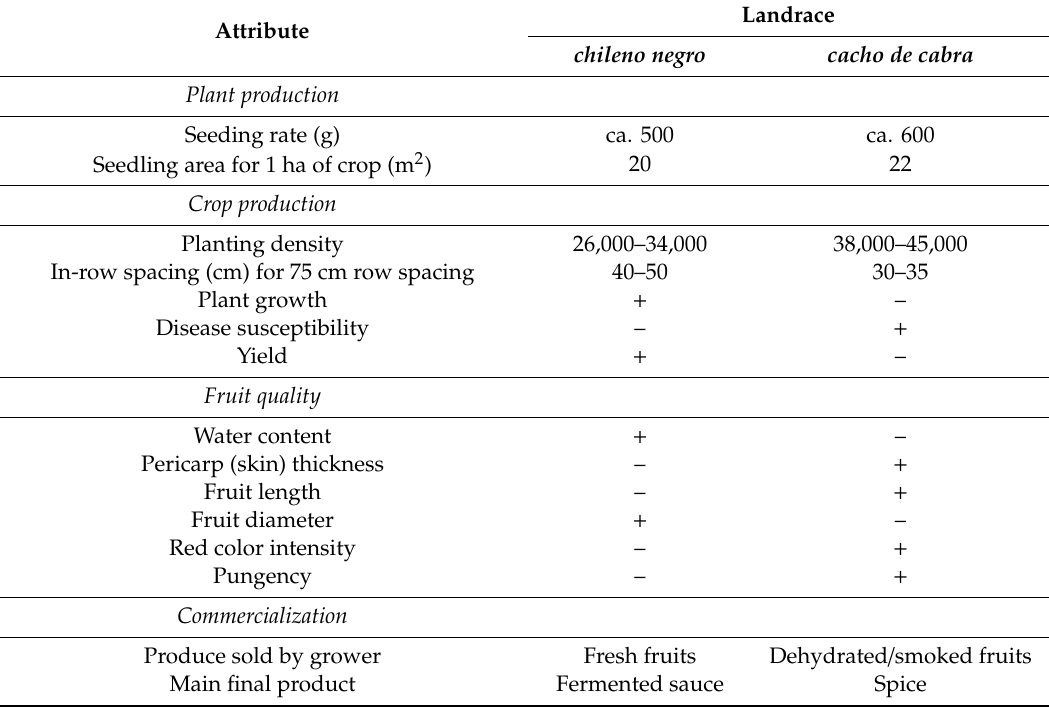
Table 2. Attributes of two Chilean landraces of chili pepper informed by local producers. Attribute